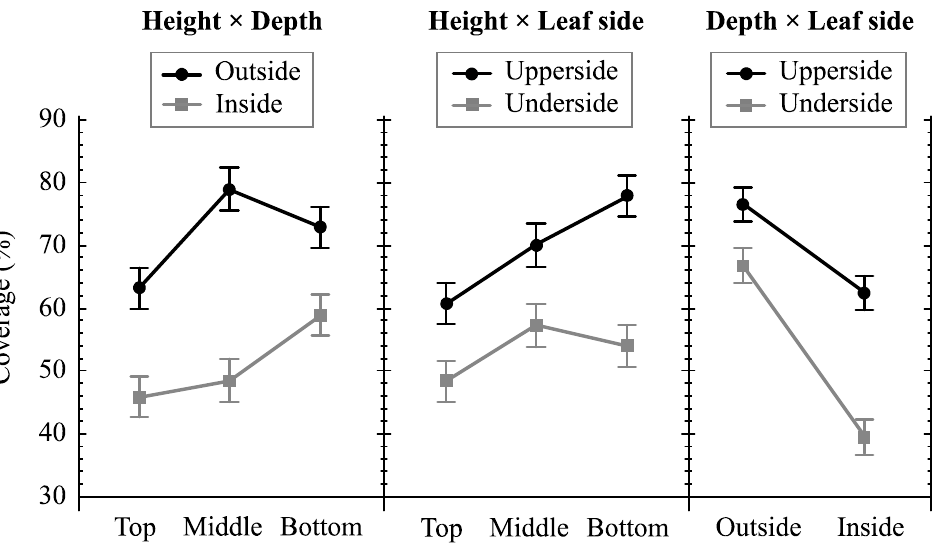
Figure 4. Interactions between height, depth and leaf side. Mean percentage of coverage and 95% Fisher’s least significant difference (LSD) intervals.